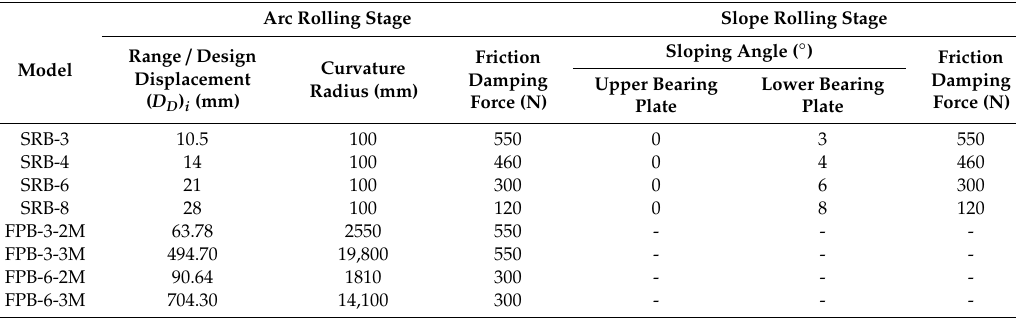
Table 2. Design parameters of SRBs and FPBs.